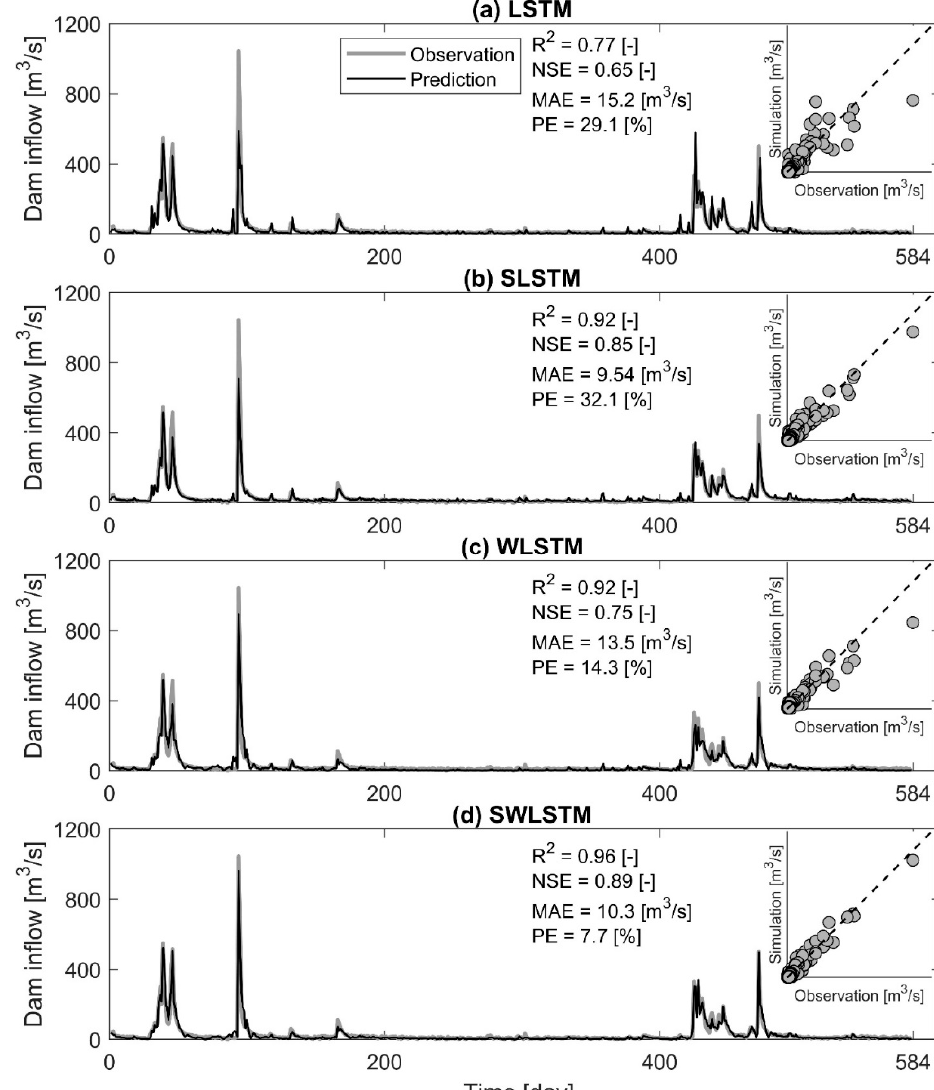
Figure 9. The comparisons of the dam inflow predicted by four models of ( a ) LSTM, ( b ) SLSTM, ( c ) WLSTM, and ( d ) SWLSTM with observations for the reserved ‘test’ dataset. The subplots demonstrate 1:1 comparisons between observations and predictions of dam inflow at each timestep. The optimal hyper-parameters specified in Table 6 and the 5-folds ( K = 5) are employed. Table 7. Accuracy improvements of SWLSTM to three other models of LSTM, SLSTM, and WLSTM for dam inflow predictions for the test dataset. A relative “difference” metric ( ∆ (cid:2897)(cid:2915)(cid:2930)(cid:2928)(cid:2919)(cid:2913) ) in Equation (20) is computed for four evaluation metrics (R2, NSE, MAE, and PE). The positive (or negative) values of ∆ (cid:2897)(cid:2915)(cid:2930)(cid:2928)(cid:2919)(cid:2913) indicate that the prediction results of SWLSTM are more (or less) accu- rate than those computed by other models. The optimal hyper-parameters specified in Table 6 and the 5-folds ( K = 5) are employed.